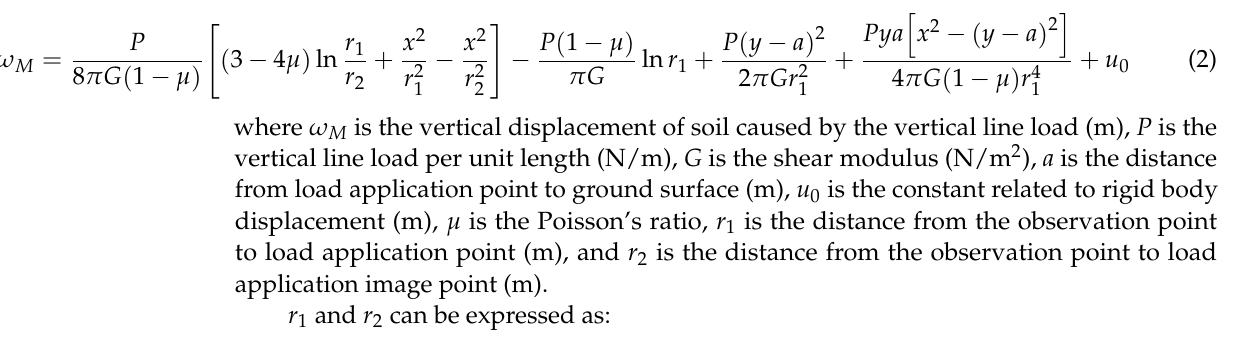
Figure 2. Calculation diagram of Melan solution: ( a ) Melan solution and ( b ) this study. The vertical displacement of soil for a vertical line loading upward beneath the surface of a semi-infinite plane can be calculated